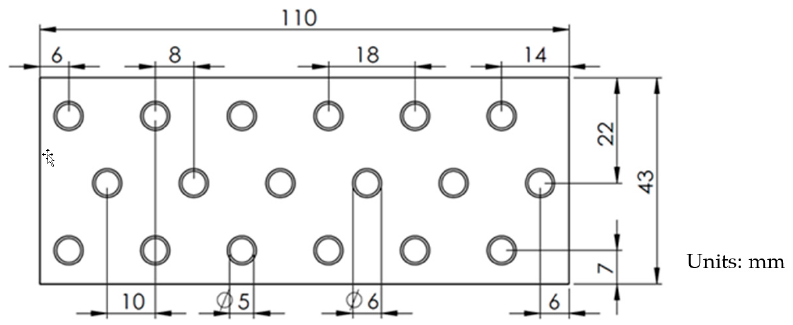
Figure 2. Arrangement of the pulsating heat pipes with respect to the 110 mm long and 43 mm wide plate fin.